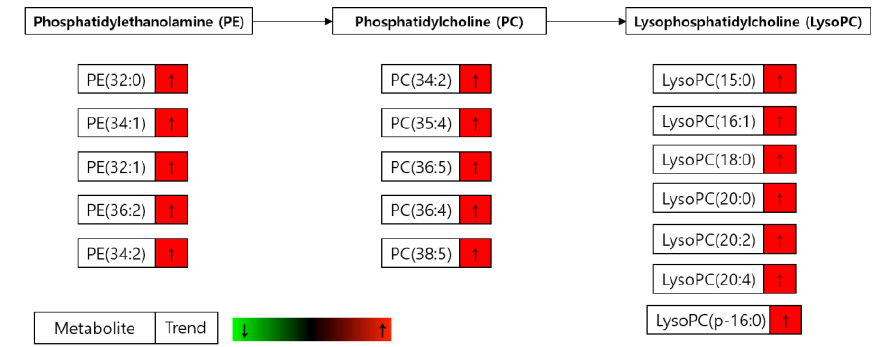
Figure 11. Significantly changed glycerophospholipids. Changes in the glycerophospholipid levels in the drug-treated cells compared to the drug plus palmitate treated cells (D group / D + P group) incubated in the serum-free media.